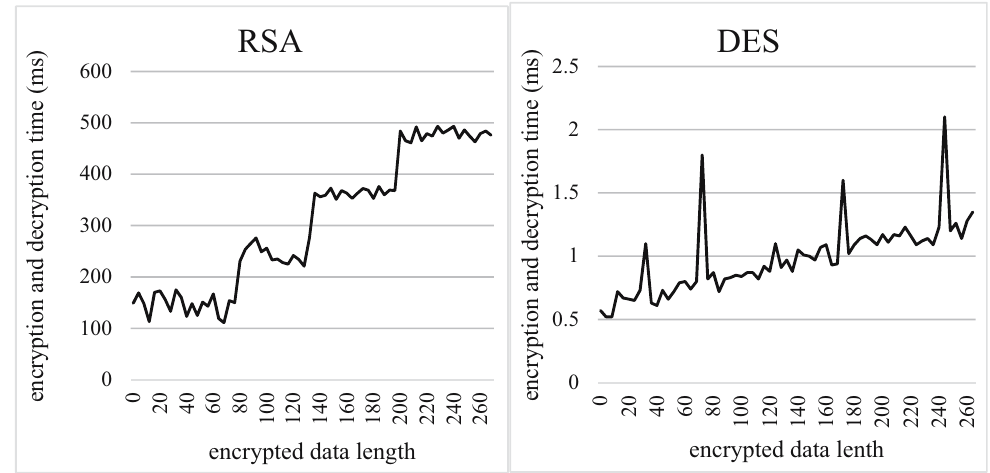
Figure 11: Time - consuming encryption and decryption of di ff erent